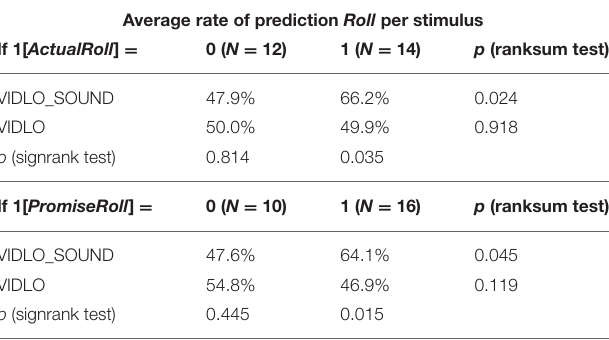
TABLE 5 | Verbal and nonverbal content in VIDLO: evidence from the French